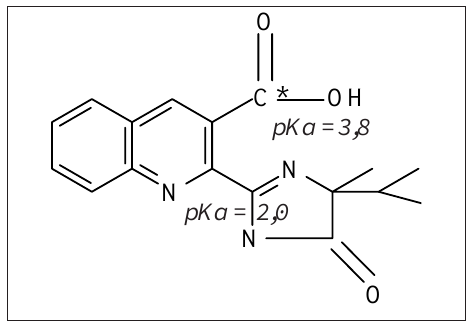
Figura 1. Estrutura química do imazaquin e localização da marcação do 14